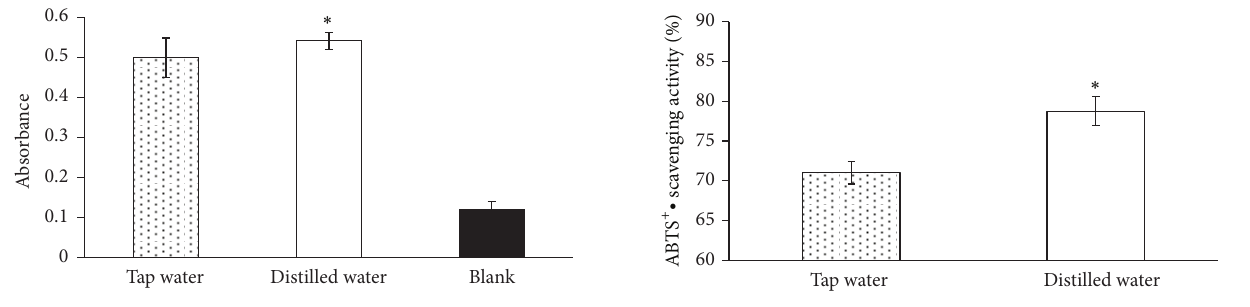
Figure 4: Effects of water solutions on ABTS + ∙ scavenging activity in green